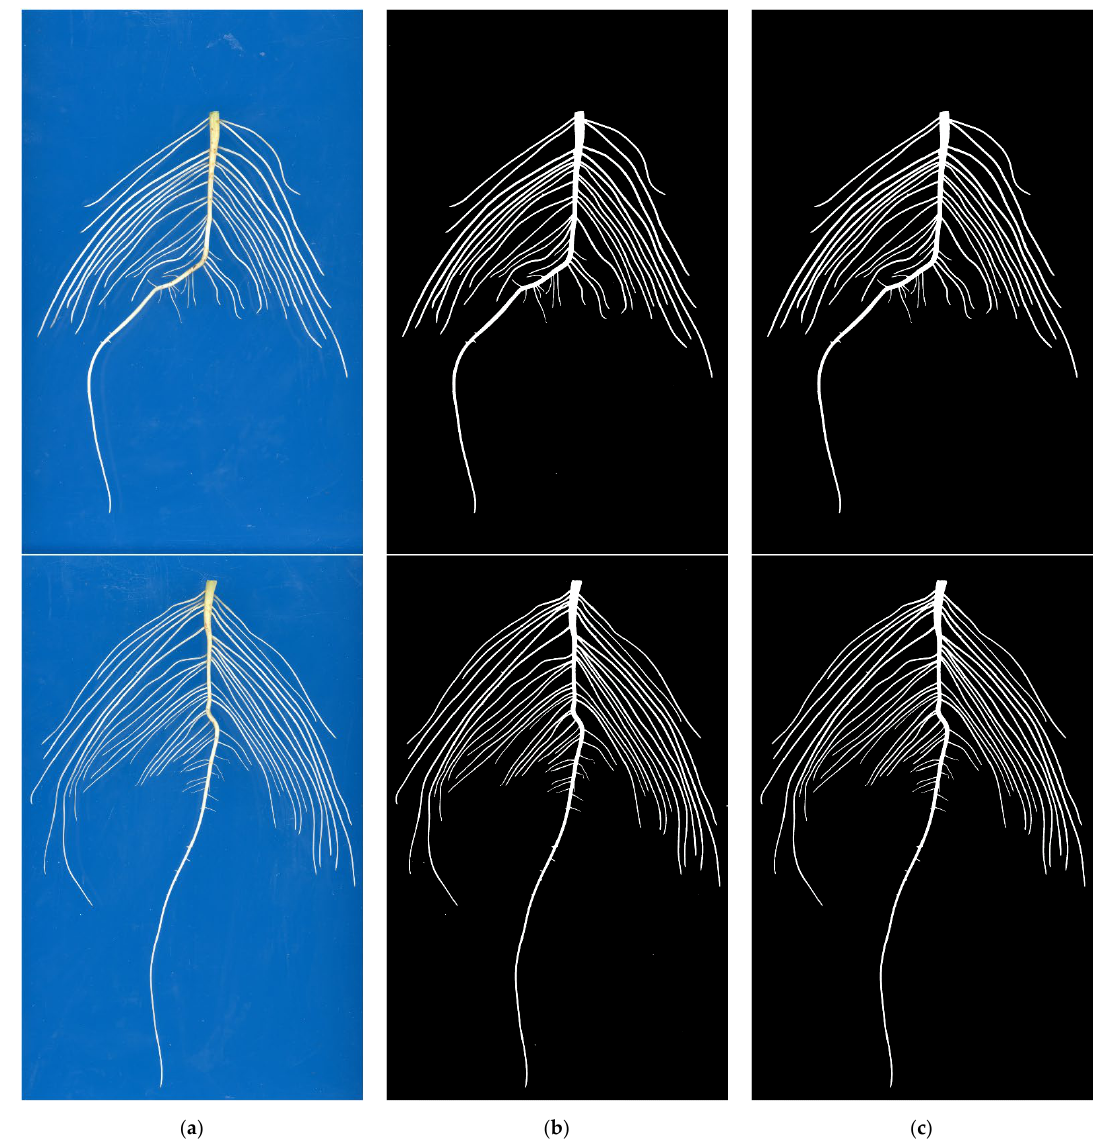
Figure 13. Image segmentation results of soybean seedling root system of multiple varieties under hydroponic environment. ( a ) Original image; ( b ) Model prediction result; ( c ) Post-processing re- sult.